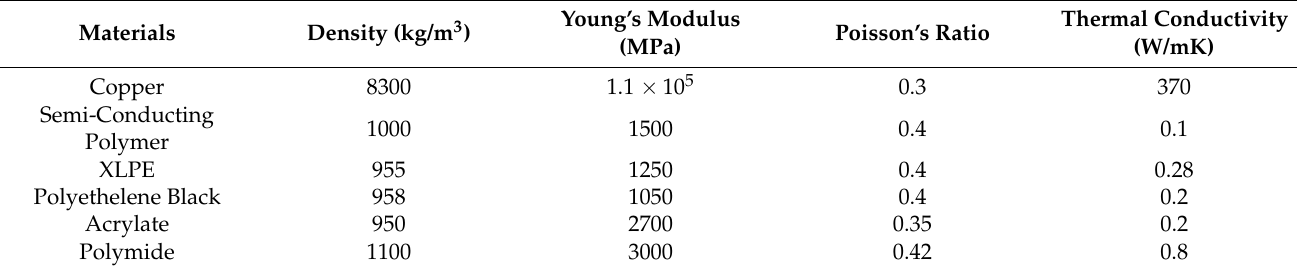
Table 1. Material table assigned to single phase